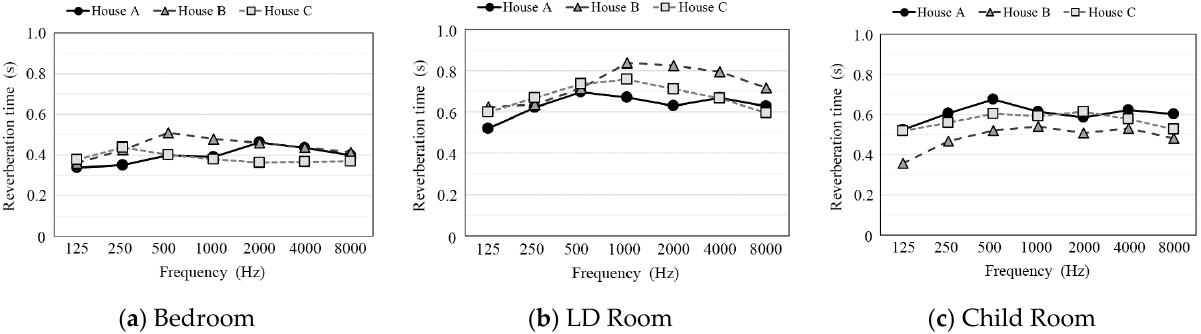
Figure 11. Frequency characteristics of the reverberation times in the nine rooms: ( a ) bedrooms; ( b ) LD rooms; ( c ) child rooms.